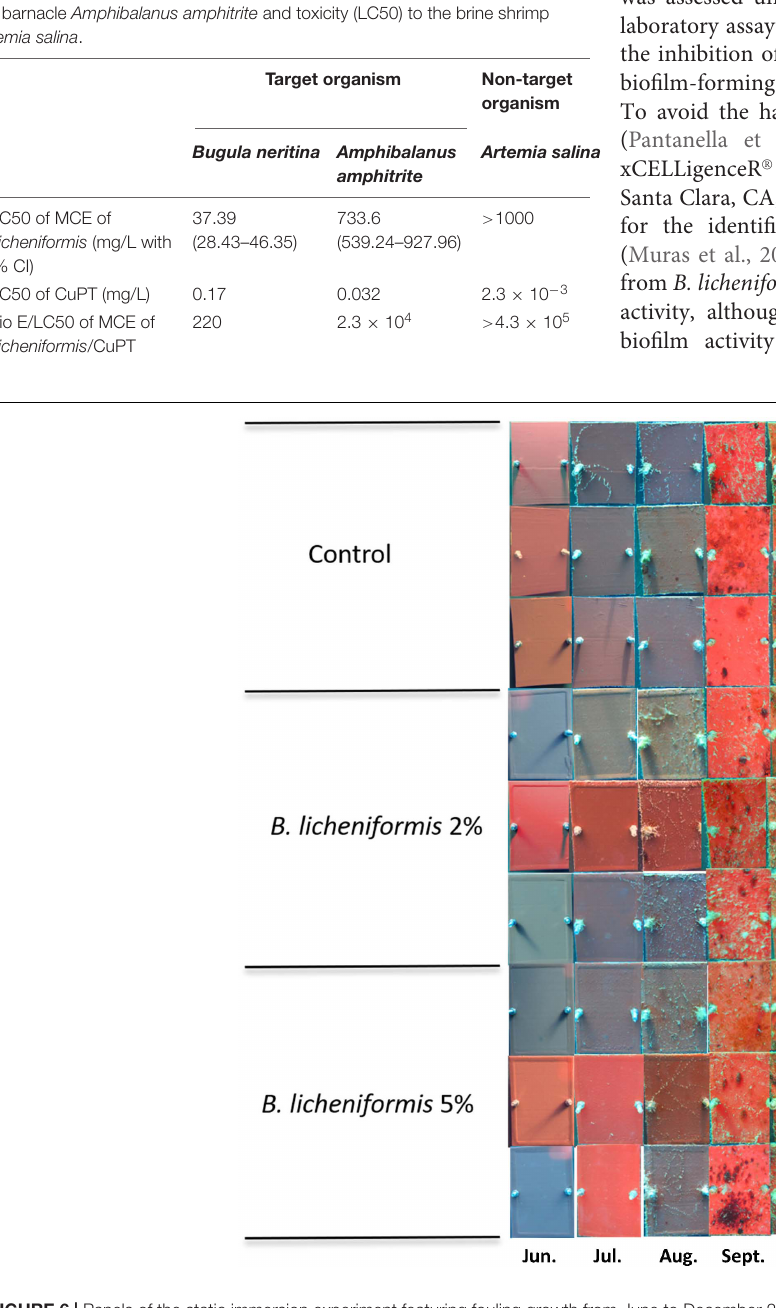
Frontiers in Marine Science |